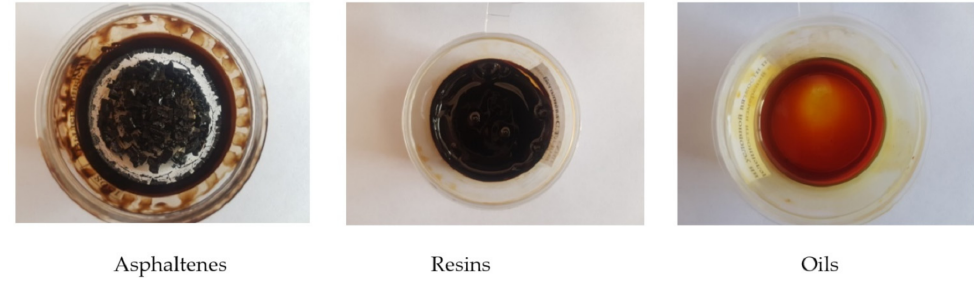
Figure 7. External view of asphaltenes, resins and oils of the compounded